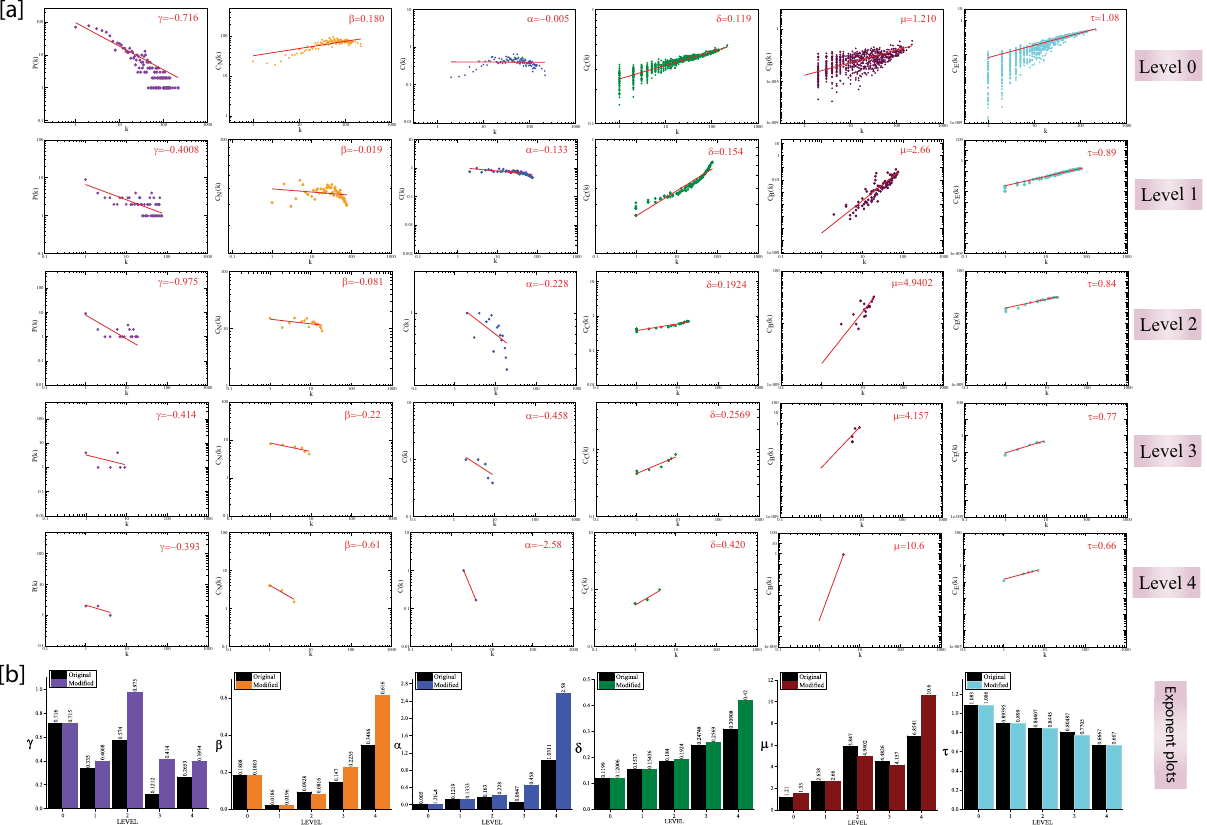
Figure 1. SARC PPI network and sub-networks followed hierarchical scale-free topologies. ( a ) The behaviors of degree distributions P(k), neighborhood connectivity C N (k), clustering co-efficient (k), closeness C C (k), betweenness C B (k) and eigenvector C E (k) measurements as a function with degree k for an original primary network (level 0) and FLT3LG-CD33-ITGA4 motif knockout networks at various levels of organization (level 1–4). ( b ) the changes in the exponent values of the six topological properties of the FLT3LG-CD33-ITGA4 motif knockout network [colors corresponding to the ones used in the topological properties plots, i.e., violet for P(k), orange for C N (k), blue for C(k), green for C C (k), maroon for C B (k) and cyan for C E (k)] compared with the topological properties’ exponents of the corresponding original networks (black) at various levels of the organization. γ, α, β, δ, µ and τ are the exponents of the degree distribution, neighborhood connectivity, clustering coefficient, closeness centrality, betweenness centrality and eigenvector centrality,